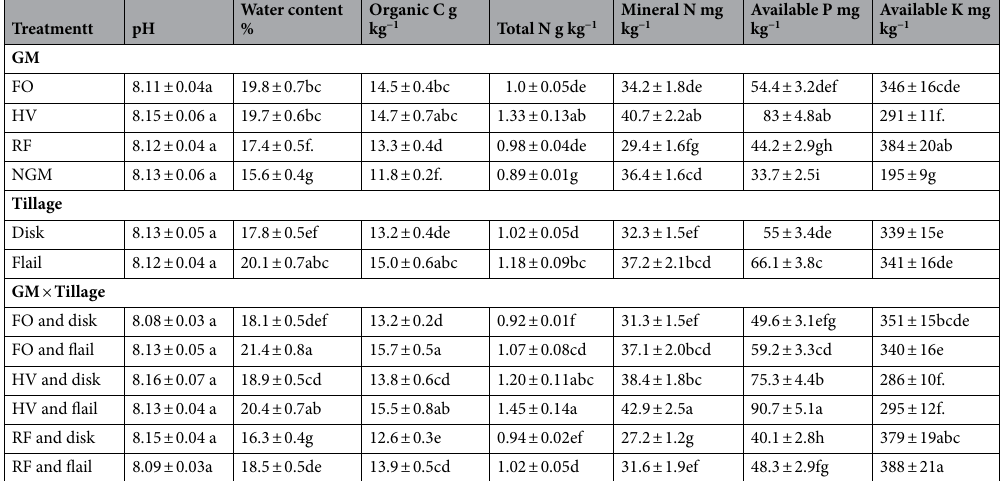
cantly higher in the February orchid and hairy vetch treatments compared to the no-green-manure treatment (Fig. 1B,C) ( P < 0.05). Rattail fescue had no significant effect on soil N-acetyl-glucosaminidase or acid phos- phatase enzyme activities (Fig. 1B,C) ( P > 0.05). Significant differences in N-acetyl-glucosaminidase and acid phosphatase enzyme activities were observed among the three green-manure treatments, in which the hairy vetch treatment had the highest N-acetyl-glucosaminidase and acid phosphatase activities ( P < 0.05). All green- manure treatments revealed significant decreases in soil phenoloxidase activity (Fig. 1D). The soil β-glucosidase, N-acetyl-glucosaminidase and acid phosphatase activities were also affected by the ter- mination method. The enzyme activities were significantly greater under flail relative to disk with β-glucosidase, tionally, Soil β-glucosidase, N-acetyl-glucosaminidase and acid phosphatase enzyme activities were significantly higher in the hairy vetch-flail treatment combination compared to other treatment combinations. Soil microbial biomass. MBC was significantly higher under the green-manure treatments, with Febru- ary orchid, hairy vetch and rattail fescue treatments being 36.7%, 80.7% and 13.3% higher than the no-green- manure treatment, respectively (Fig. 2A). The same trend was observed for MBN, with February orchid, hairy vetch and rattail fescue showing increases of 91.9%, 154.1% and 60.9%, respectively (Fig. 2B). All green-manure treatments significantly decreased the soil MBC/N (Fig. 2C) ( P < 0.05). However, no difference in soil MBC/N was observed among the three green-manure treatments (Fig. 2C) ( P > 0.05). Tillage did not have a significant influence on MBC, MBN or MBC/N (Fig. 2) ( P > 0.05). Soil microbial community structure. The microbial community structures estimated by the FAME pro- files are shown in Table 2. Green manure had the greatest effect on total FAMEs in the February orchid and hairy vetch treatments compared to rattail fescue and the no-green-manure treatments ( P < 0.05). The micro- bial community structure composition was significantly shifted by the green-manure treatments (Table 2). The abundance of FAME biomarkers for Gram+ bacteria (sum of i15:0, a15:0, i16:0, i17:0 and a17:0) and the total bacteria (sum of Gram+ bacteria, Gram− bacteria and actinomycetes) were significantly greater in the green- manure treatments than in the no-green-manure treatment ( P < 0.05). However, no differences in the abundance of Gram+ bacteria or total bacteria were observed among the three green-manure treatments ( P > 0.05). No significant difference was observed in the abundance of Gram− (sum of 16:1ω7c, 16:1ω9c, cy17:0 and cy19:0) and actinomycetes (sum of 10Me16:0, 10Me17:0 and 10Me18:0) between the green-manure treatments and the no-green-manure treatment ( P > 0.05). Green manure treatments resulted in a significantly greater rela-